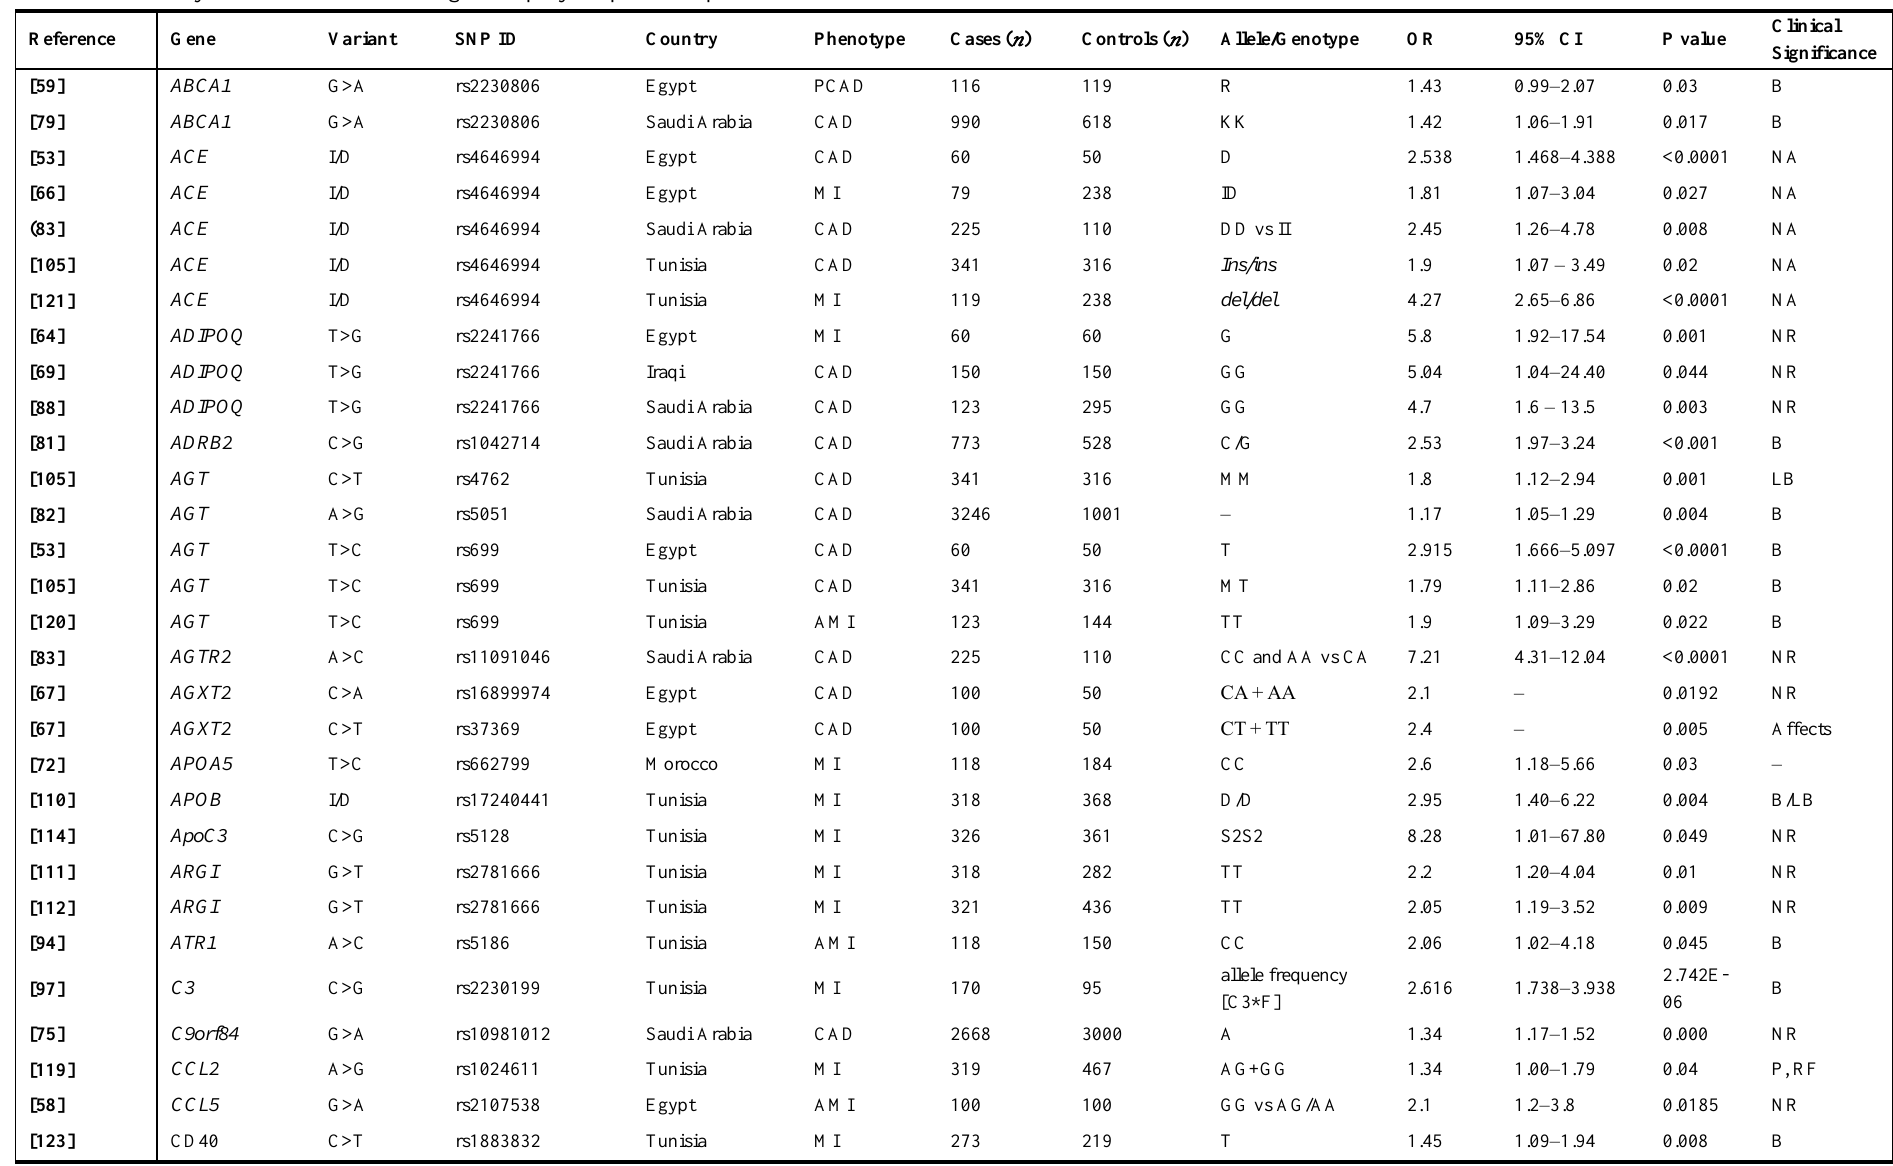
Table 1. Summary of the CAD/MI-related genetic polymorphisms reported in Arab